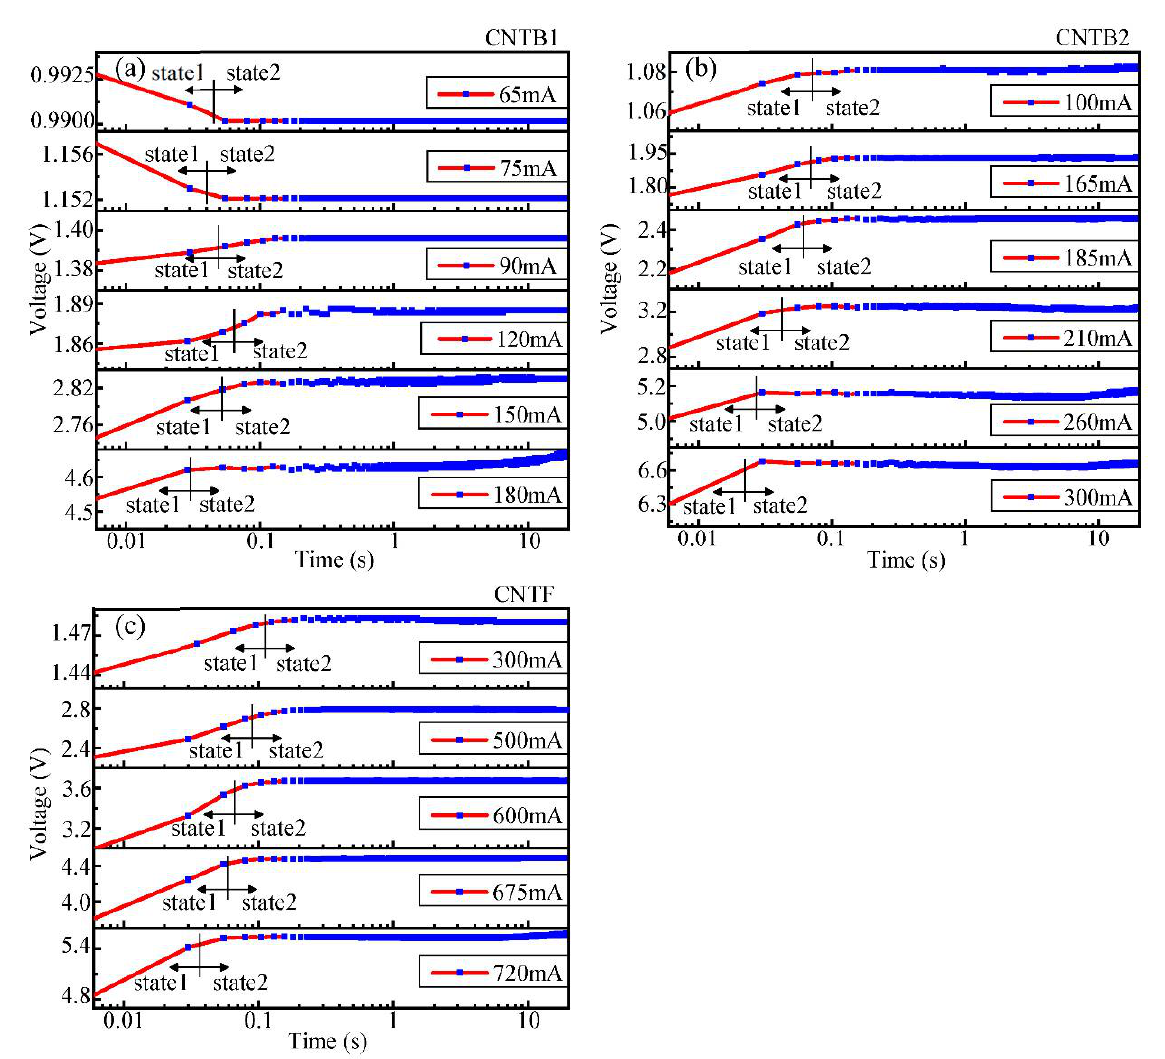
Figure 5. The transient voltage variations with time during annealing: ( a ) CNTB1; ( b ) CNTB2; ( c ) CNTF. The arrows indicate State 1 and State 2. During the current annealing, the time required for each sample in State 1 is reduced.